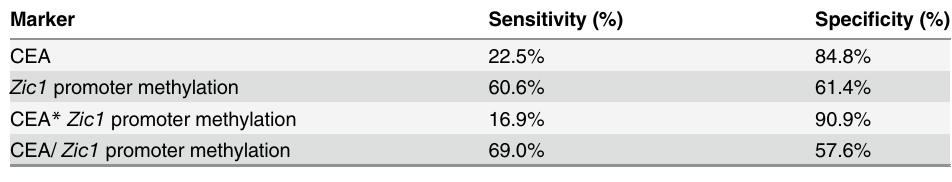
Table 2. Sensitivity and specificity of markers detected in the gastric cancer (GC) group.